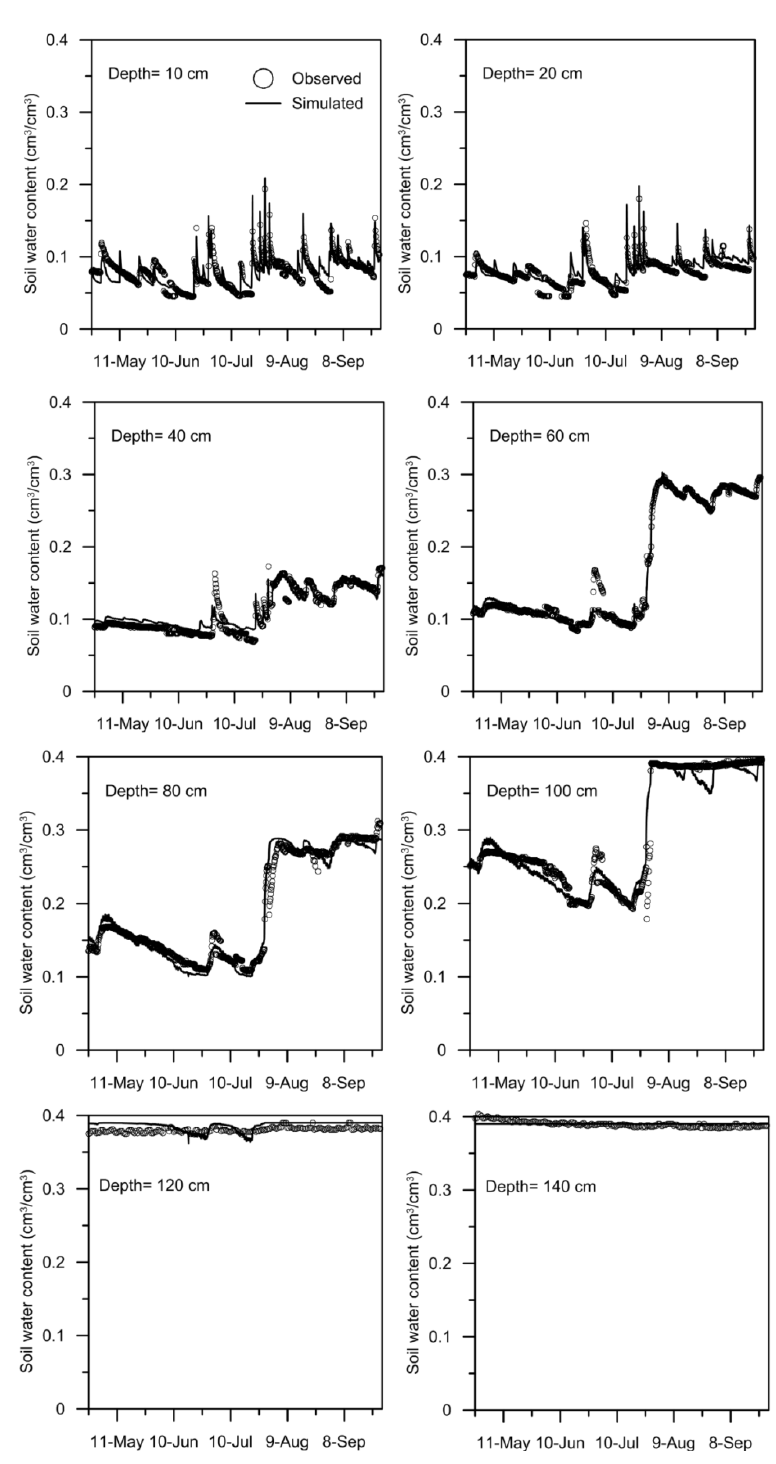
Figure 4. The fit of measured soil water content at eight different depths based on soil profile (points) using model-computed values (solid lines) for the calibration period (26 April to 12 July) and the validation period (13 July to 27 September).